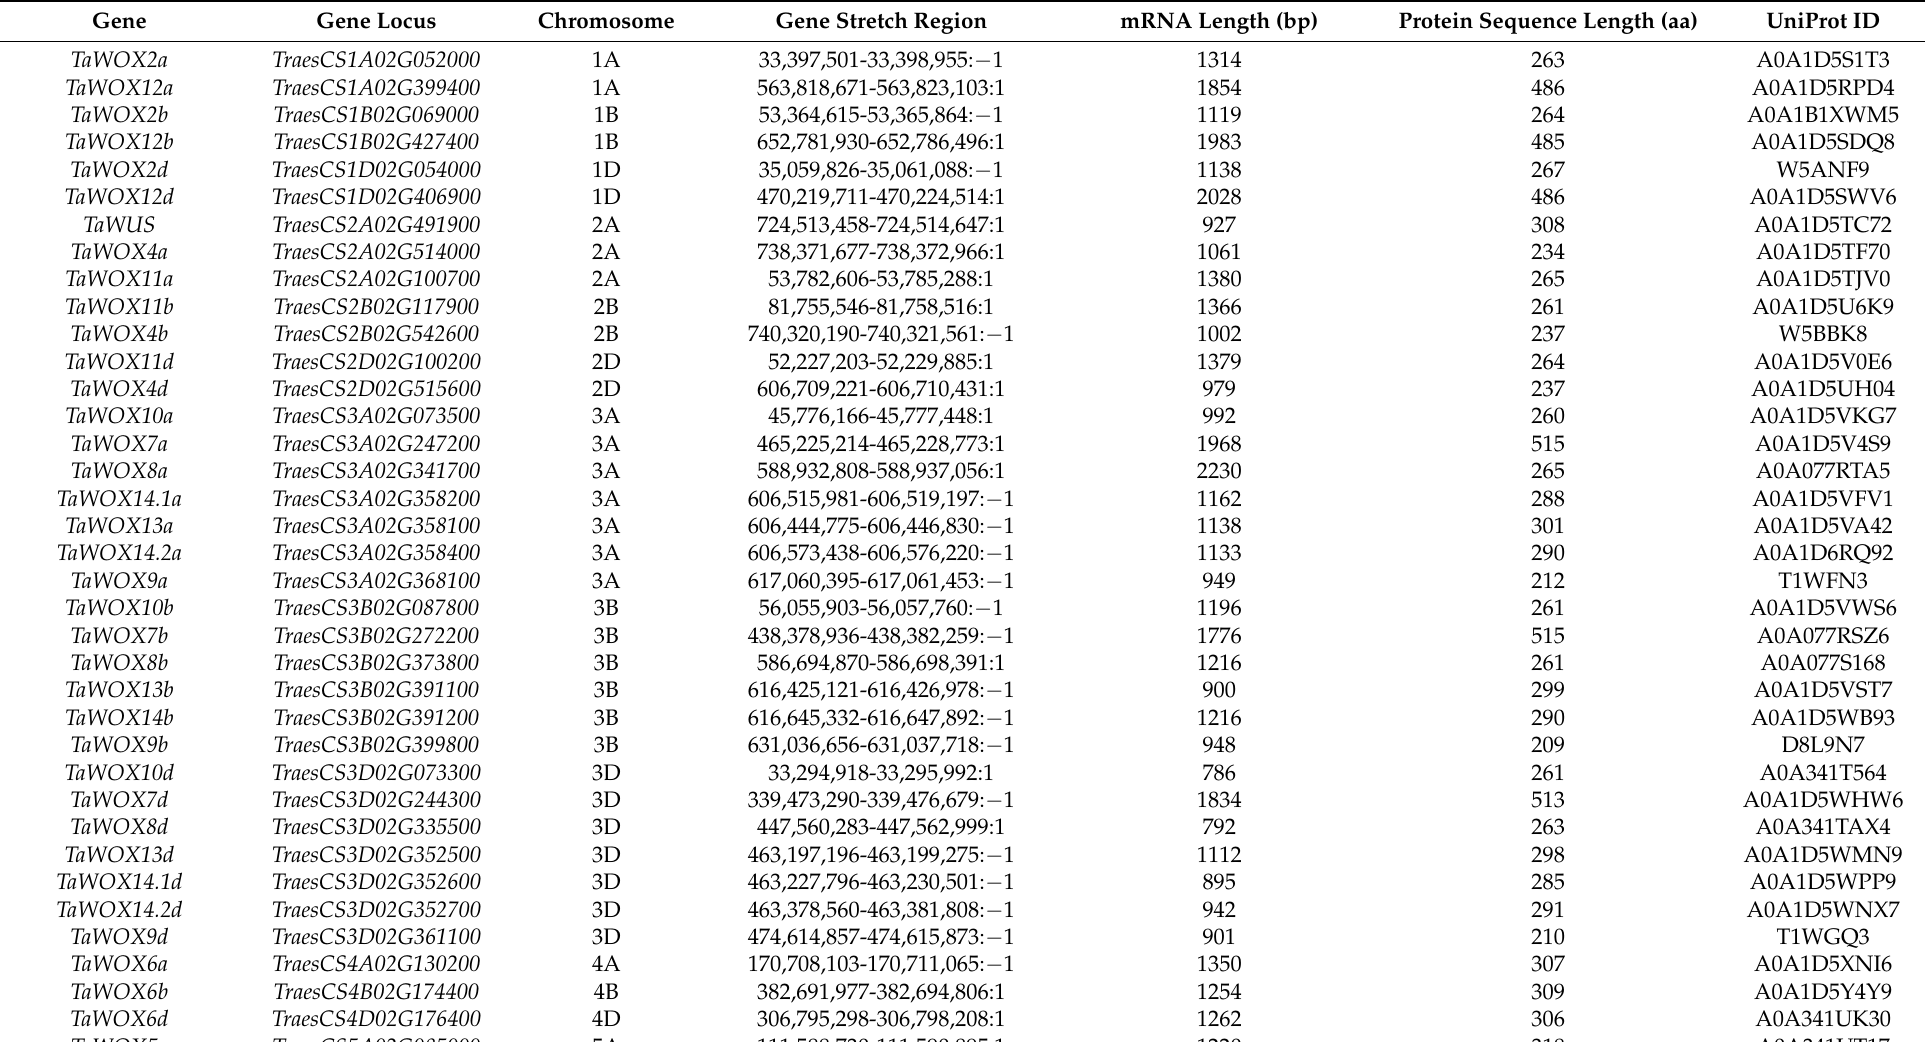
Table 1. Characteristics of TaWOX gene family members in T. aestivum